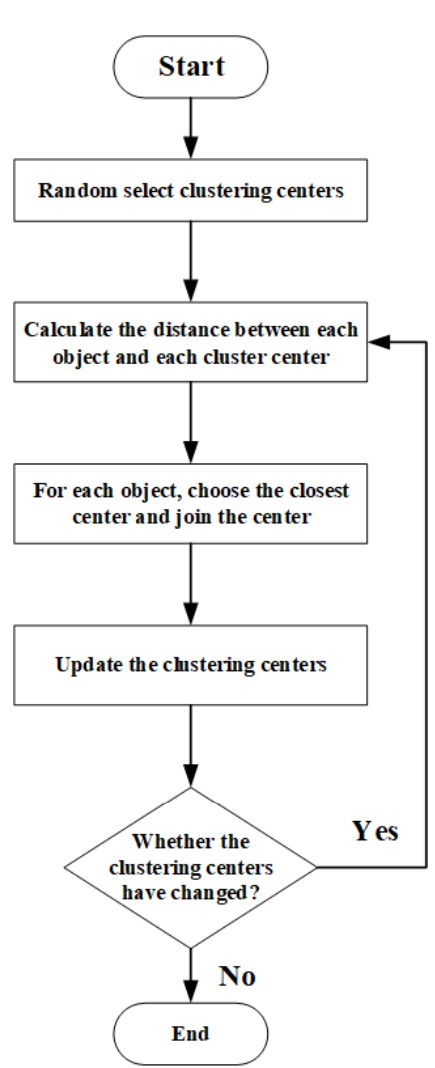
Figure 1. Flowchart of k-means algorithm.